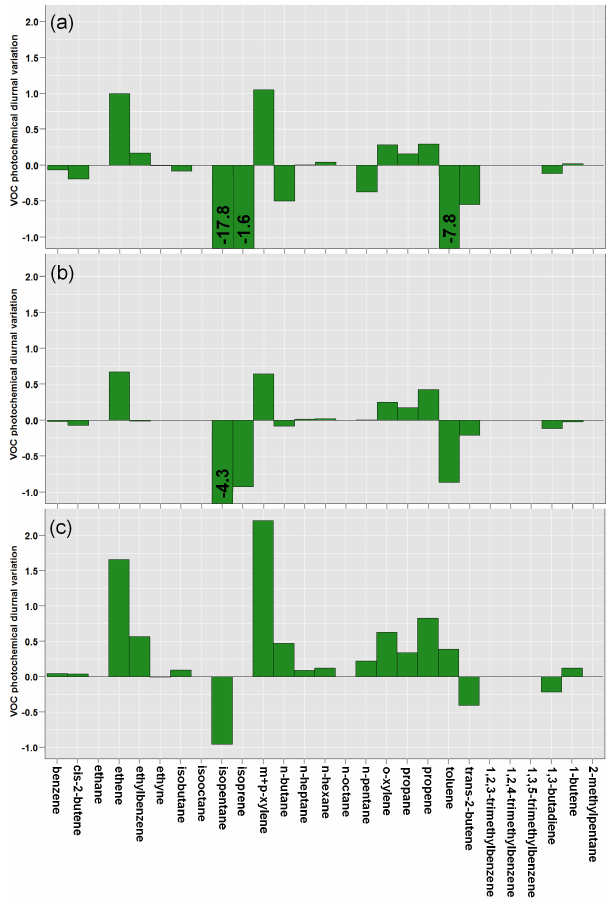
Figure 8. Individual VOC diurnal photochemical reactivity as de- fined by the difference between night (average of 01:00–05:00) and afternoon (13:00–17:00) POCP-weighted VOC / ethane ratios in (a) July 1999, (b) July 2000 and (c) July 2001 at Harwell. A lower ratio in the afternoon results in a positive value (i.e. pho- tochemical depletion), while a higher afternoon ratio results in a negative value. These months correspond to the periods of annual maximum regional O 3 increment. To emphasise the positive con- tributions to VOC photochemical cycling, the negative values have been truncated.